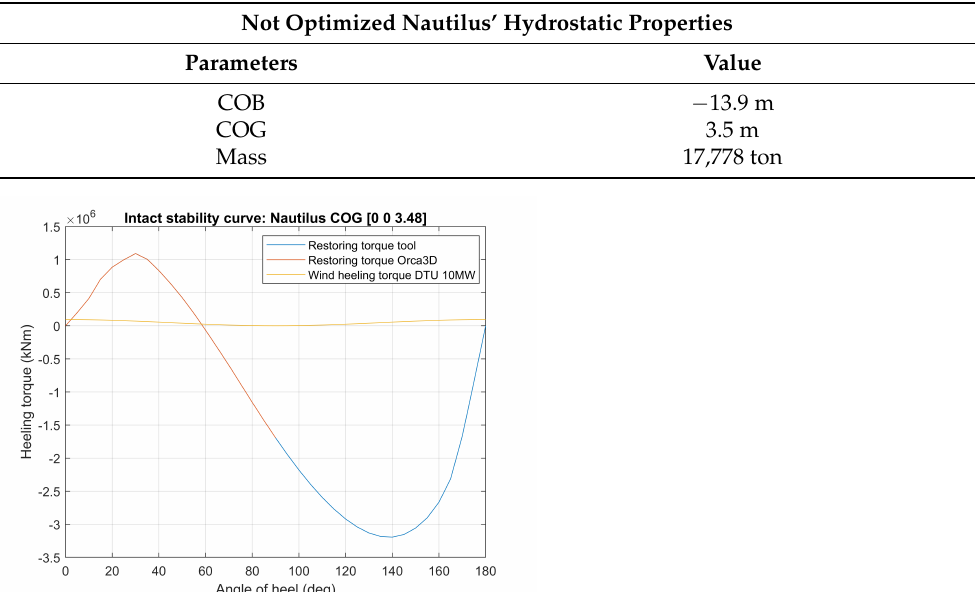
Table 5. Hydrostatic properties of the not optimized Nautilus platform